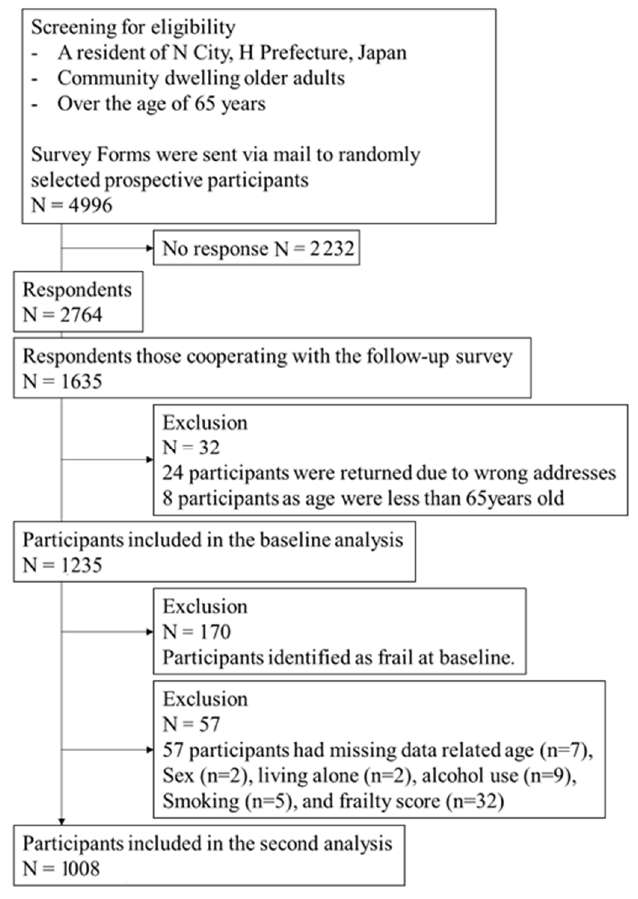
Figure 1. Flowchart for the recruitment of study subjects.